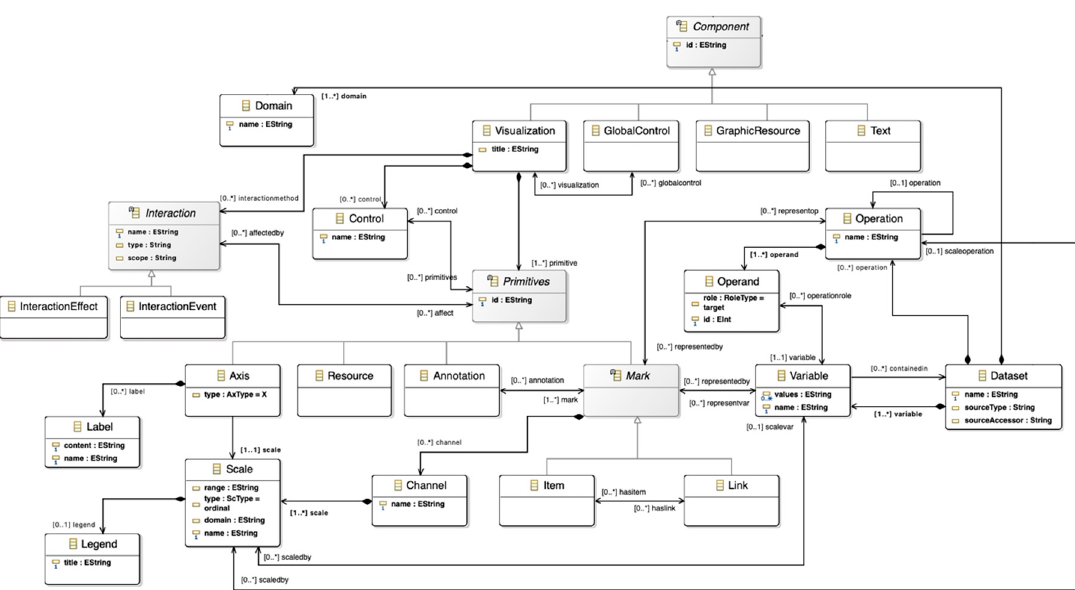
Figure 5. Components’ section of the dashboard meta-model. A high resolution version can be found